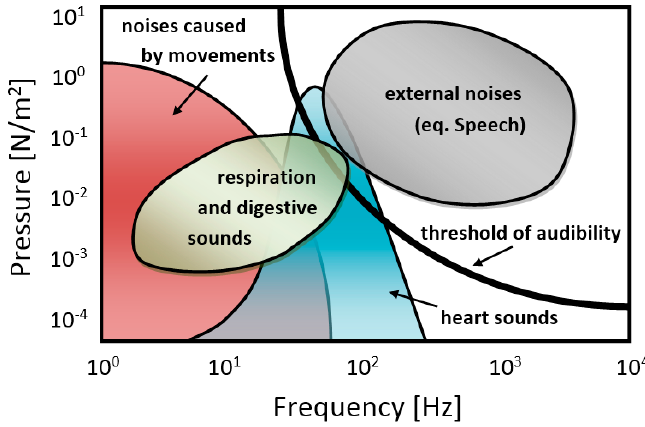
Figure 1. Spectral intensity map of PCG and related disturbance signals (source [3, 6]).